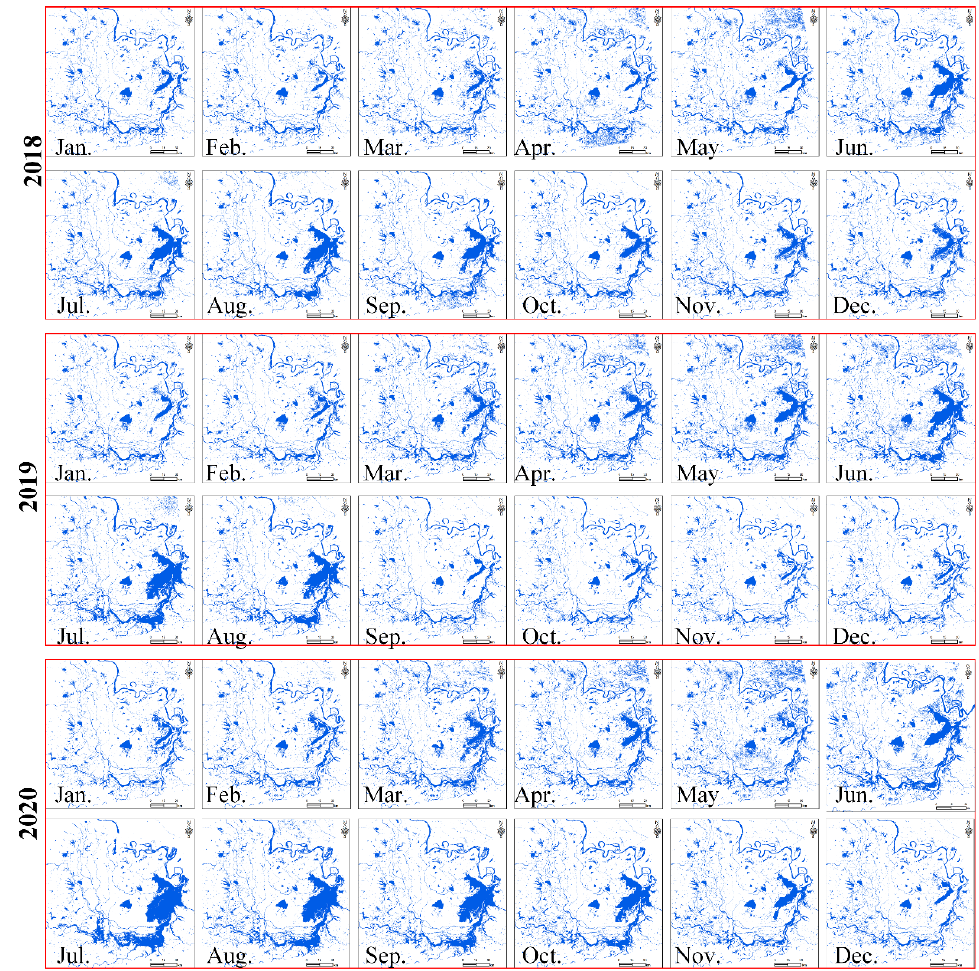
Figure 13. Monthly water extraction results of Dongting Lake from 2018 to 2020.